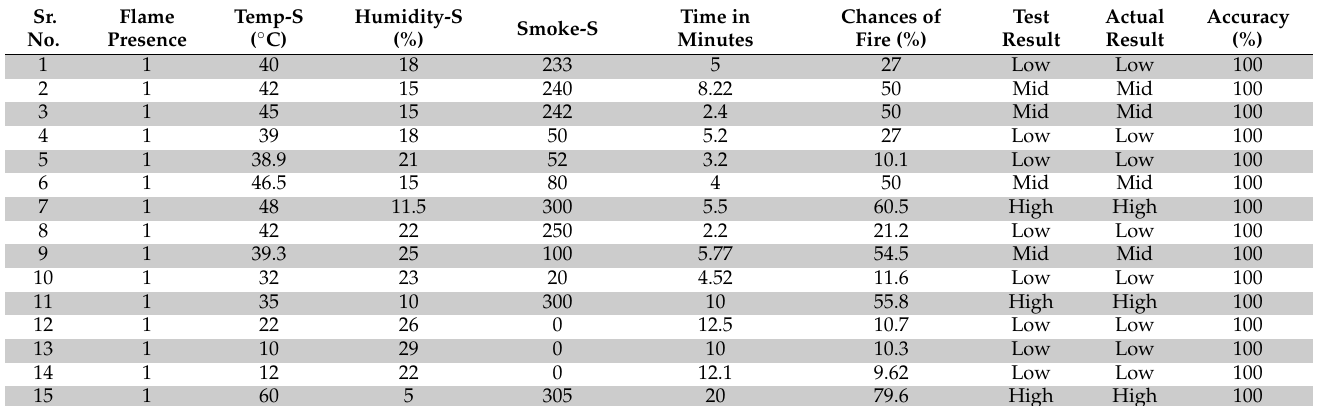
Table 9. Results of 15 experiments based on